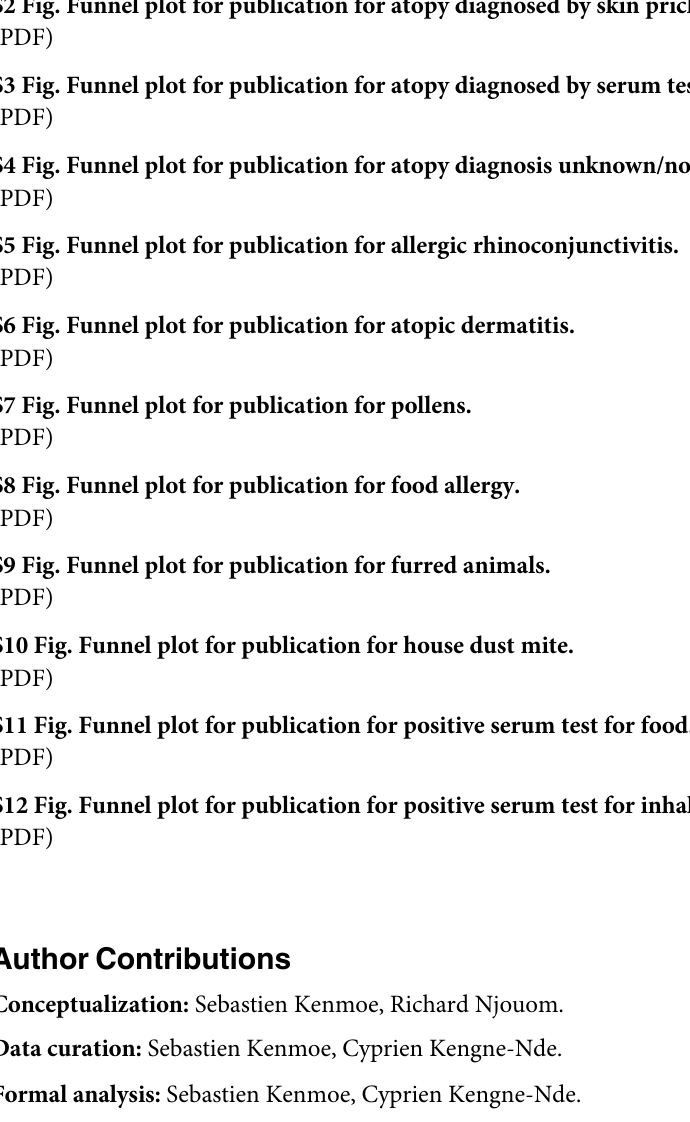
S1 Fig. Forest plot of the comparison of atopy in people with and without LRTI in infancy. (PDF) S2 Fig. Funnel plot for publication for atopy diagnosed by skin prick tests. (PDF) S3 Fig. Funnel plot for publication for atopy diagnosed by serum tests. (PDF) S4 Fig. Funnel plot for publication for atopy diagnosis unknown/not reported. (PDF) S5 Fig. Funnel plot for publication for allergic rhinoconjunctivitis. (PDF) S6 Fig. Funnel plot for publication for atopic dermatitis. (PDF) S7 Fig. Funnel plot for publication for pollens. (PDF) S8 Fig. Funnel plot for publication for food allergy. (PDF) S9 Fig. Funnel plot for publication for furred animals. (PDF) S10 Fig. Funnel plot for publication for house dust mite. (PDF) S11 Fig. Funnel plot for publication for positive serum test for food. (PDF) S12 Fig. Funnel plot for publication for positive serum test for inhalants.